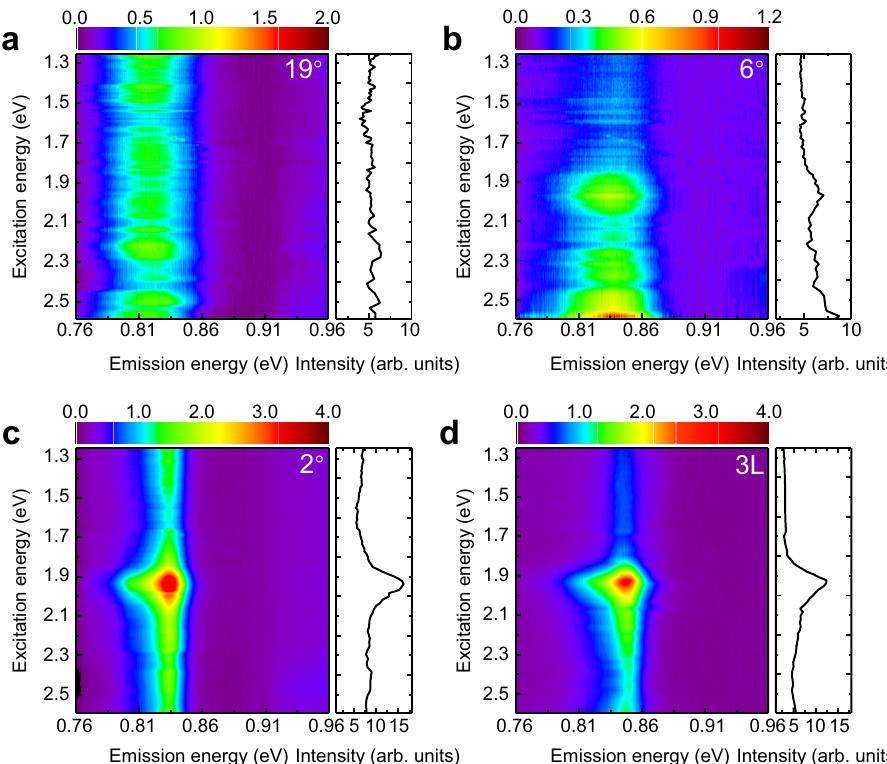
Fig. 2 Twist-angle-dependent PLE spectra. PLE spectra of twisted monolayer/bilayer phosphorene heterostructures with the angle of 19° ( a ), 6° ( b ), 2° ( c ), and a trilayer (labeled as 3L) phosphorene ( d ), respectively. The right panel in each fi gure shows the integrated PL intensity between the energy range of 0.8 – 0.9 eV. The top color scar indicates the PL emission intensities. All twisted phosphorene heterostructures show low energy PL emission close to 0.83 eV, but the high energy optical absorption spectra are completely different in different heterostructures: the 19° twisted heterostructure exhibits a broad absorption with no clear resonances, the 6° heterostructure has a weak absorption peak at 1.97 eV and a strong absorption peak at 2.64 eV, while the 2° heterostructure and trilayer phosphorene shows a single prominent absorption peak at 1.92